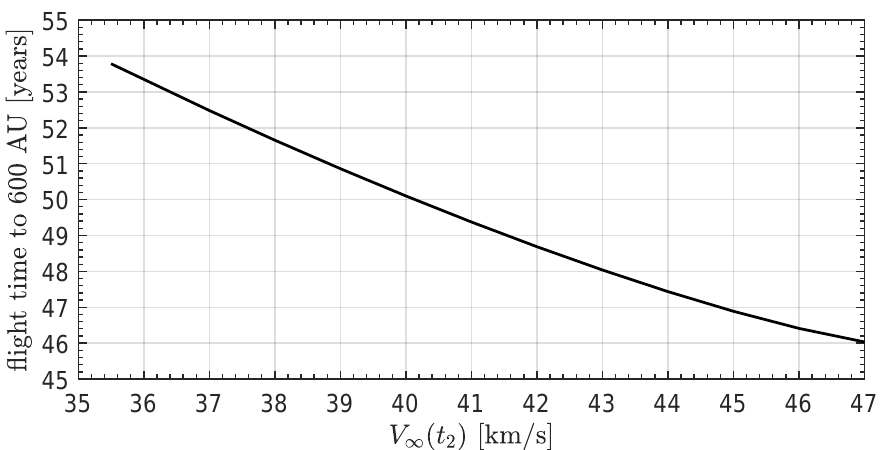
Figure 18. Total mission time as a function of the hyperbolic excess velocity at the end of phase